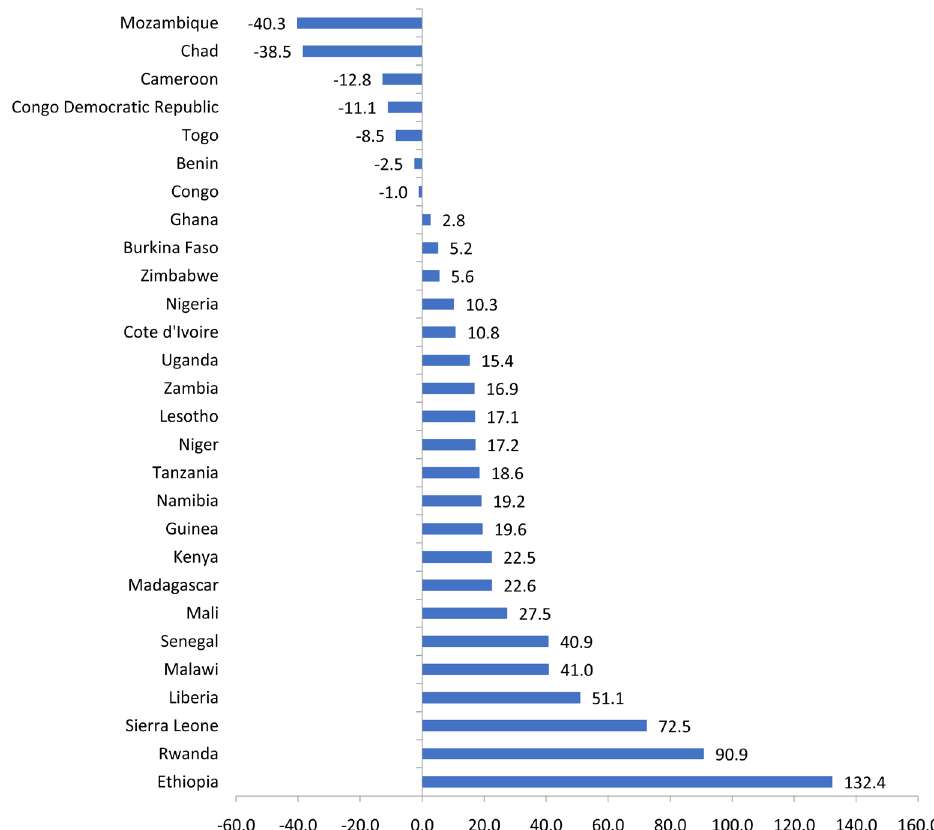
Figure 3. Percent change in preference implementation since